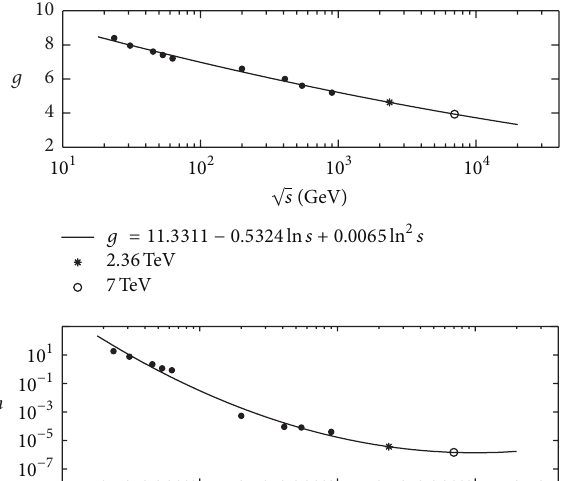
one part is from the freeze-out of the fluid-like matter, and the other is from leading